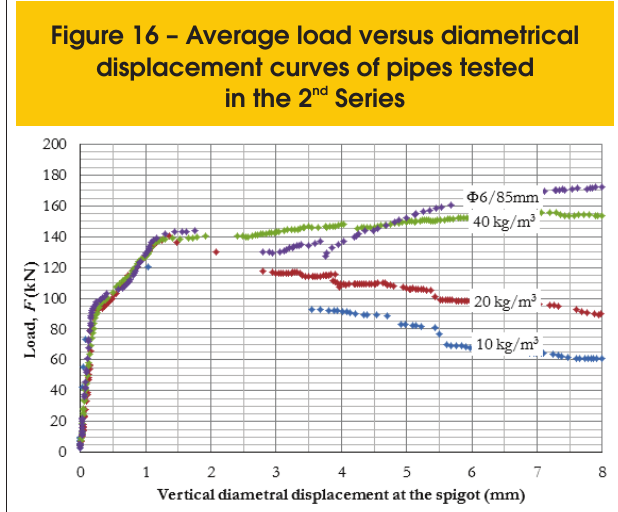
Figure 16 – Average load versus diametrical displacement curves of pipes tested nd in the 2 Series